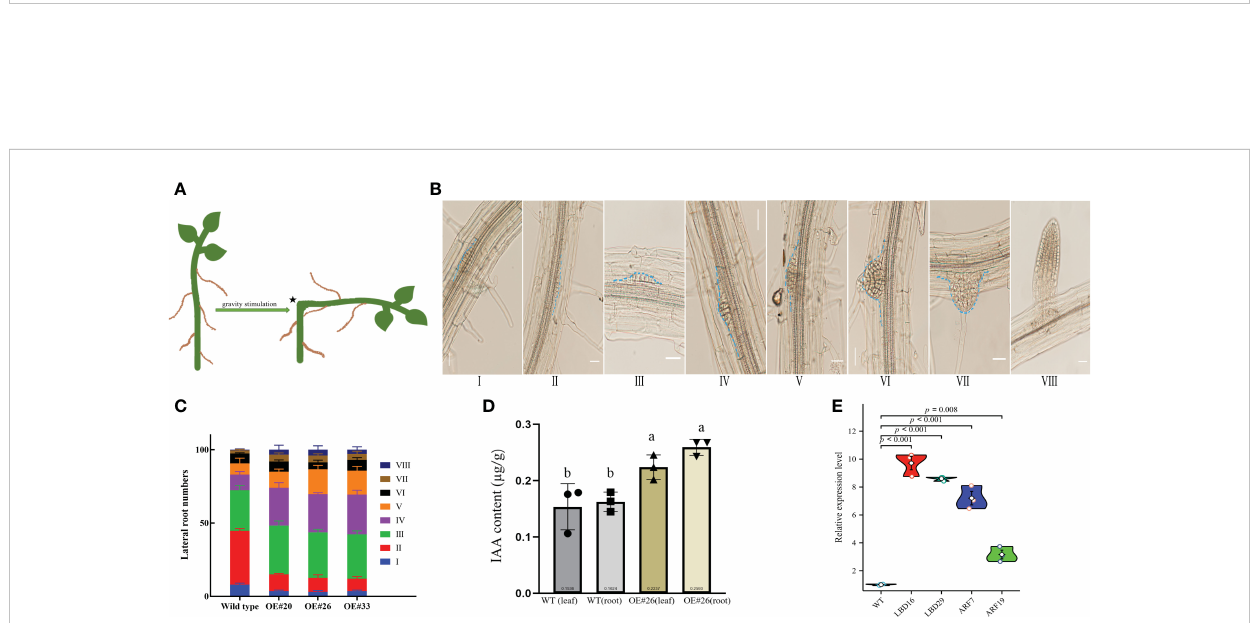
FIGURE 5 Comparison of lateral root density of wild type (WT) and OE lines Arabidopsis plants at various developmental stages. (A) Diagram showing a classic approach that was used to induce lateral root initiation and formation. Bending the horizontally placed primary root tip 90° and allowing the root tip to grow in the direction of gravity can induce the initiation and formation of lateral roots at the convex side of the bending site, as indicated by an asterisk. (B) Lateral root formation at different developmental stages detected from a root of single plant. (C) Measurements of the percentage of lateral root formation of WT and OE lines Arabidopsis at various developmental stages ( n = 100). Measurements were carried out after gravity stimulation for 48 h. (D) IAA content in WT and OE#26 seedlings. (E) Expression level of LED16 , LBD29 , ARF7 , and ARF19 genes. At least three independent biological replicates were carried out, and consistent results were obtained. Results from one representative experiment are shown. Ten-day-old seedlings were used for analysis. Data shown represent average and SD ( n = 100). Letters indicate the results for comparisons across groups using Tukey ’ s post hoc tests.